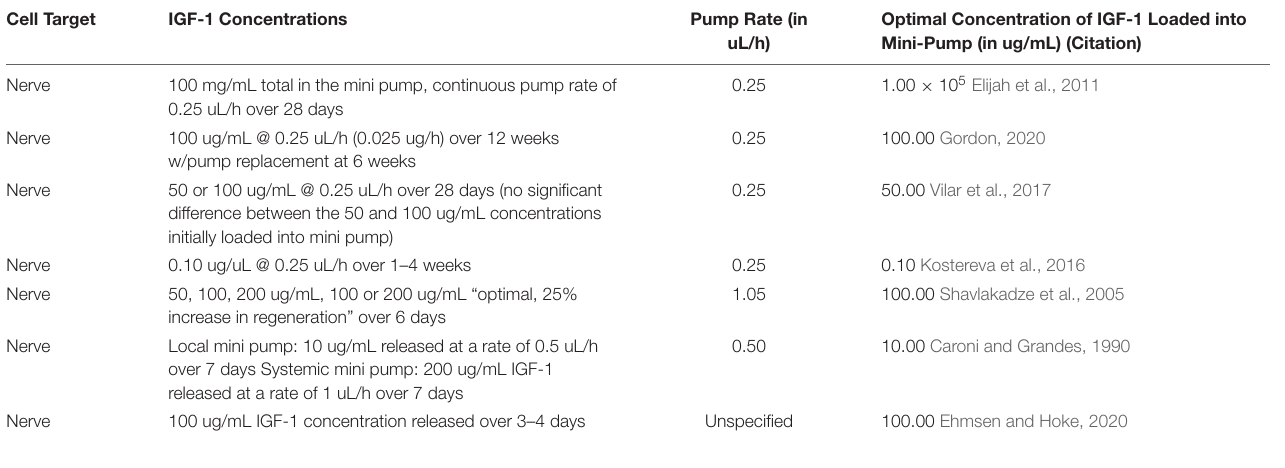
TABLE 5 | In vivo studies using mini pumps for local administration of